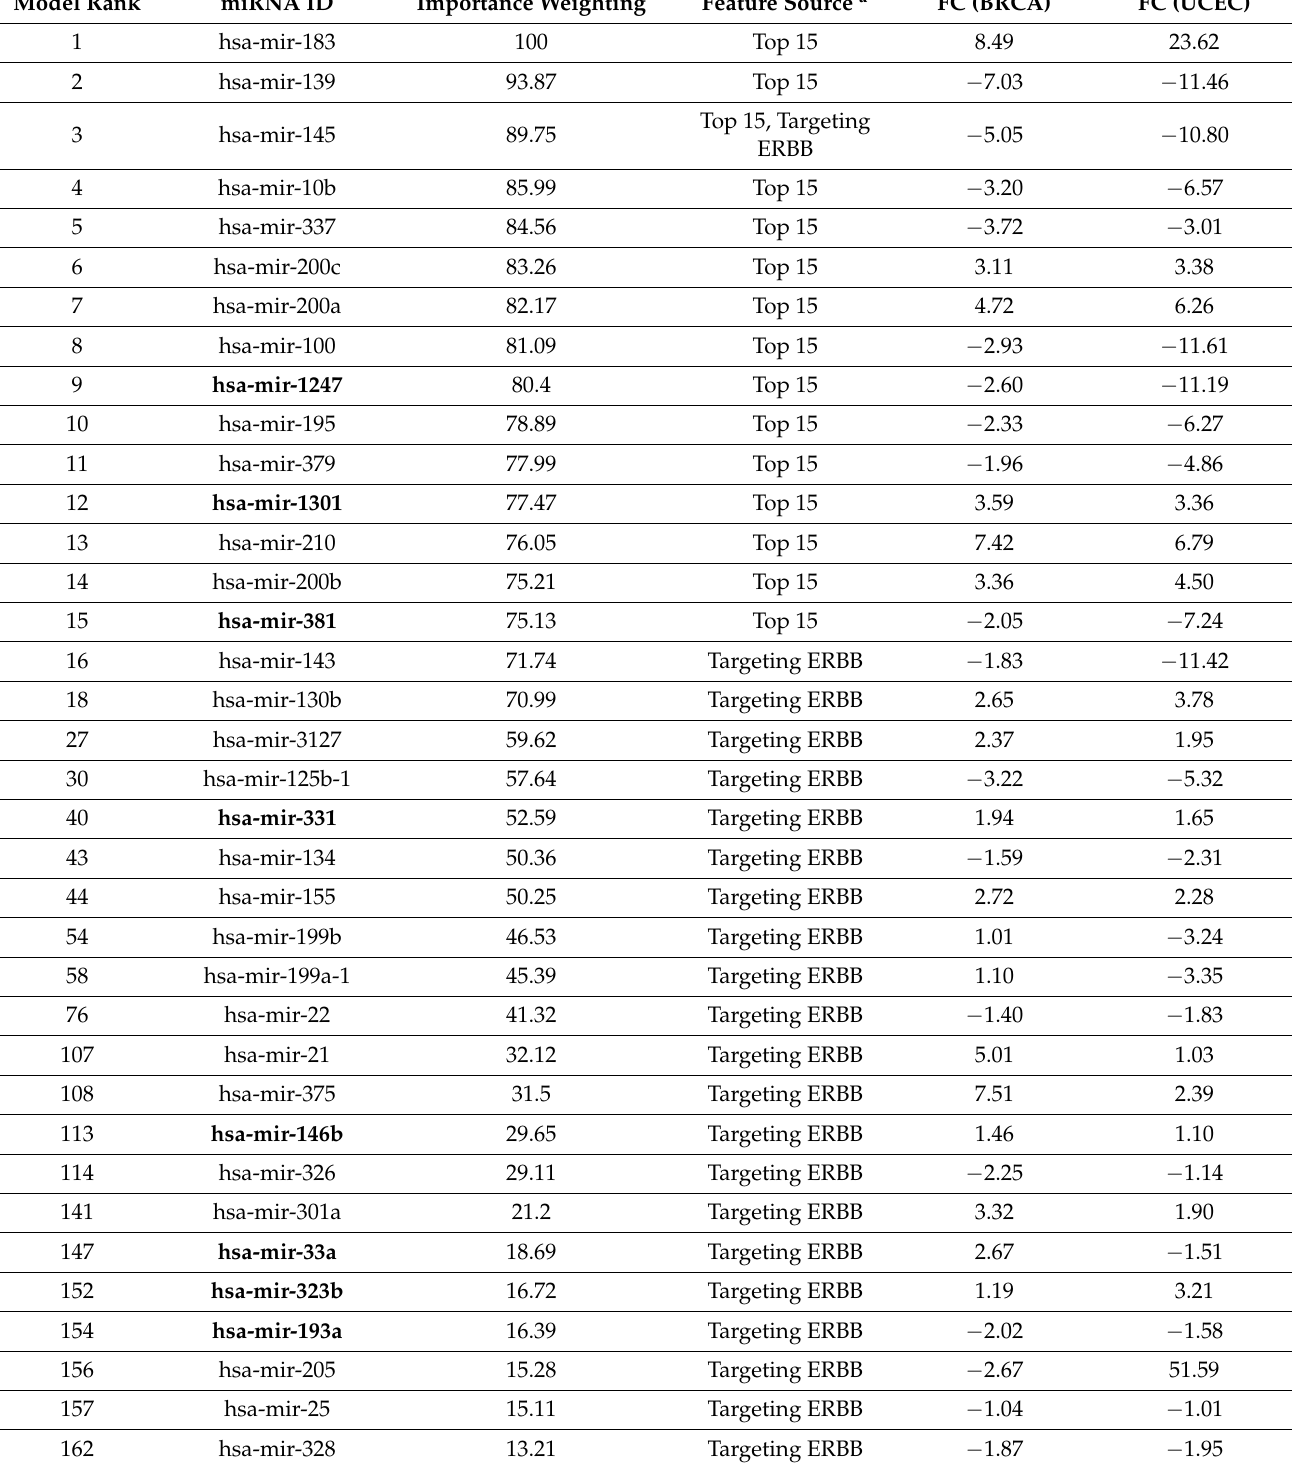
Table 1. The selected 42 features (miRNAs) associated with breast, ovarian, and uterine corpus endometrial cancers, with the corresponding feature source, and fold-change in expression (tumor vs. available normal sample normalized read counts), ranked according to the weighted support vector machine (wSVM) model. The miRNAs with ID indicated in bold were evaluated for in vitro validations. The importance weighting column indicates every feature’s